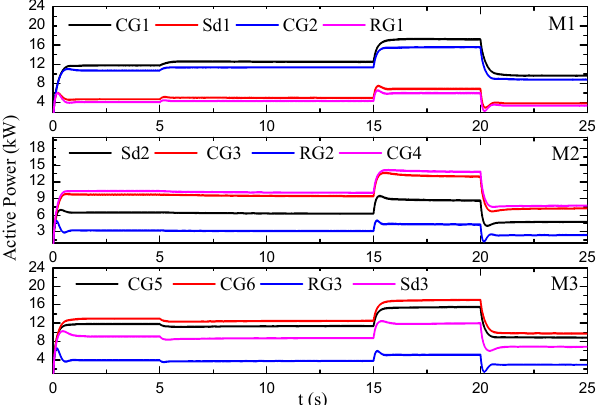
Figure 4. The operating performance in MGC: ( a ) Active power outputs of DERs; ( b ) The true marginal costs of DERs; ( c ) The system frequency; ( d ) The voltage magnitudes; ( e ) Reactive power outputs of DERs.